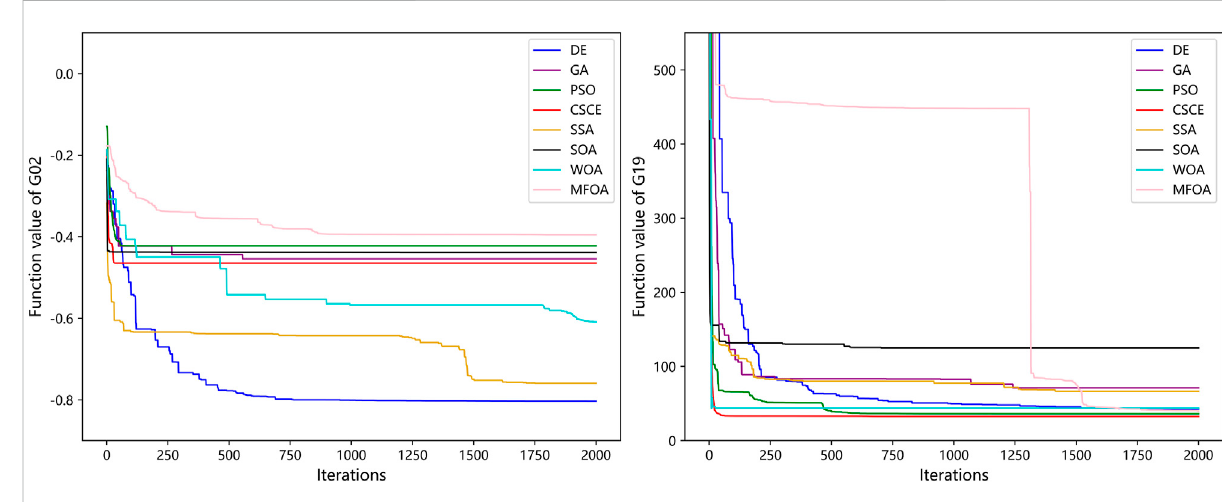
FIGURE 6 Iteration curves of different optimization algorithms for solving G02 and G19.